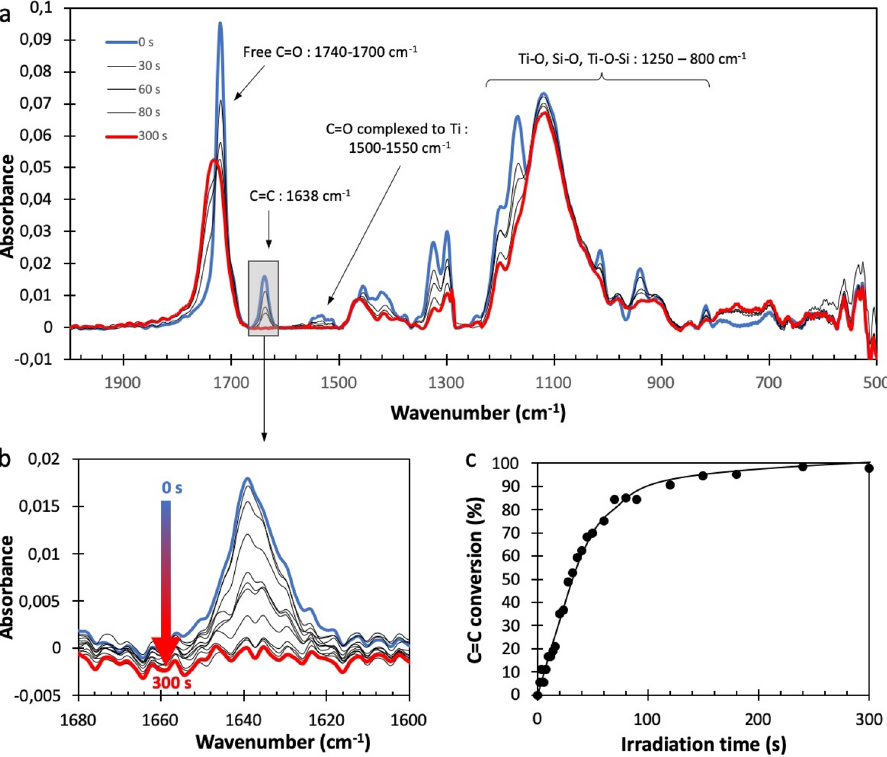
Figure 3. ( a ) FTIR of a nanocomposite thin film (450 nm thickness, molar ratio Si/Ti : 6/1, CoFe 2 O 4 MNPs : 0.4 vol%) and its modification upon DUV irradiation (carried out with LC8 lamp at 70 mW/cm 2 ). ( b ) Widening of the 1680–1600 cm −1 region to highlight the decrease of the C=C band (LC8 lamp at 70 mW/cm 2 ). ( c ) Conversion of the C=C band plotted as a function of the irradiation time (line is for guiding